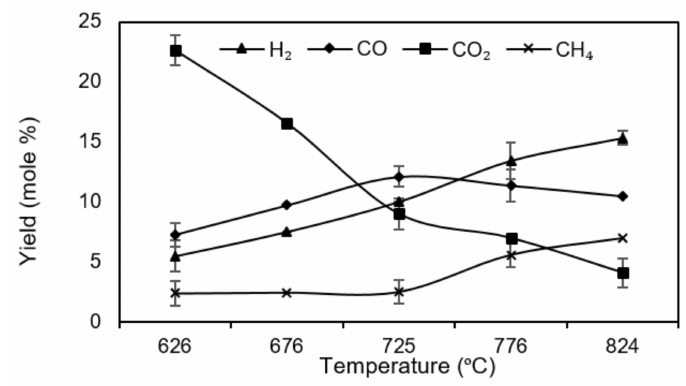
Figure 4. The e ff ect of temperature on syngas composition.